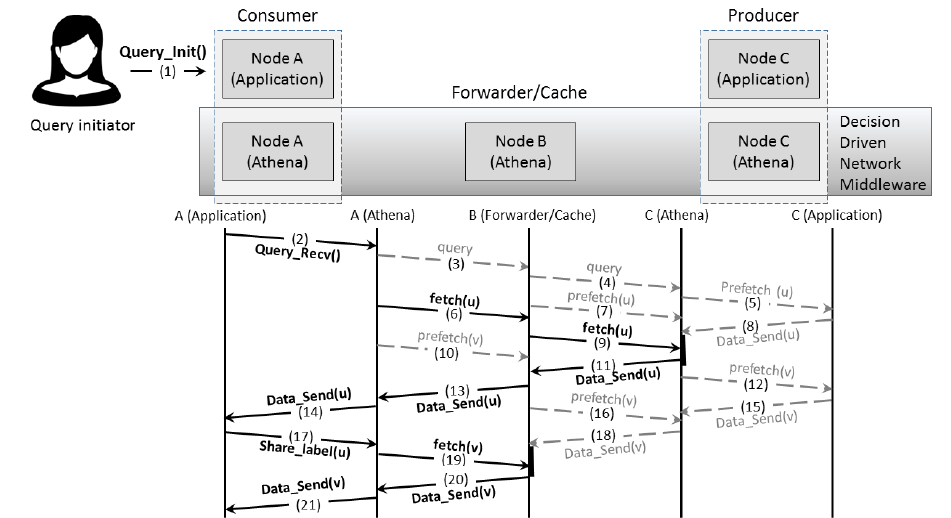
Figure 3. A visualization showing the flow of requests and data as nodes in Athena work together to resolve a query. In this example, the user uses Query_Init() to create and issue a query at Node A. The query in our example involves two data objects, u and v . Node A calls Query_Recv() locally to start the processing. The query is propagated through the network (Edges 3 and 4), reaching Node B and C. Upon receiving the query, Node C attempts prefetching, first for data object u in this particular example. Since Node C is the data source for u , it sends u back towards the requester node (Edges 8, 11, 13, and 14), during which, Node A’s fetch request meets the returned data at Node C (Edge 9). Upon receiving u at Node A, the user examines the data, makes a judgment regarding the corresponding condition state of the query. This state label provided by the human decision-maker is then propagated back into the network (Edge 17). The handling for data object v follows a similar pattern, for which the fetch request has a cache hit at the forwarder Node B, without reaching the actual source Node C, due to prefetch requests. In the figure, grey arrows and requests represent those processed in the background; namely pre-fetches and their responses. Solid black arrows and requests are those processed in the foreground; namely actual object fetch requests and their